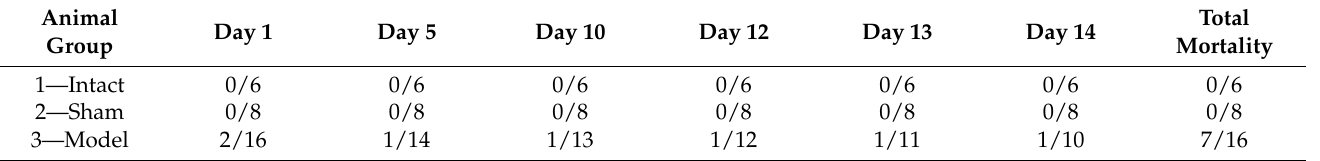
Table 2. Animal mortality during the